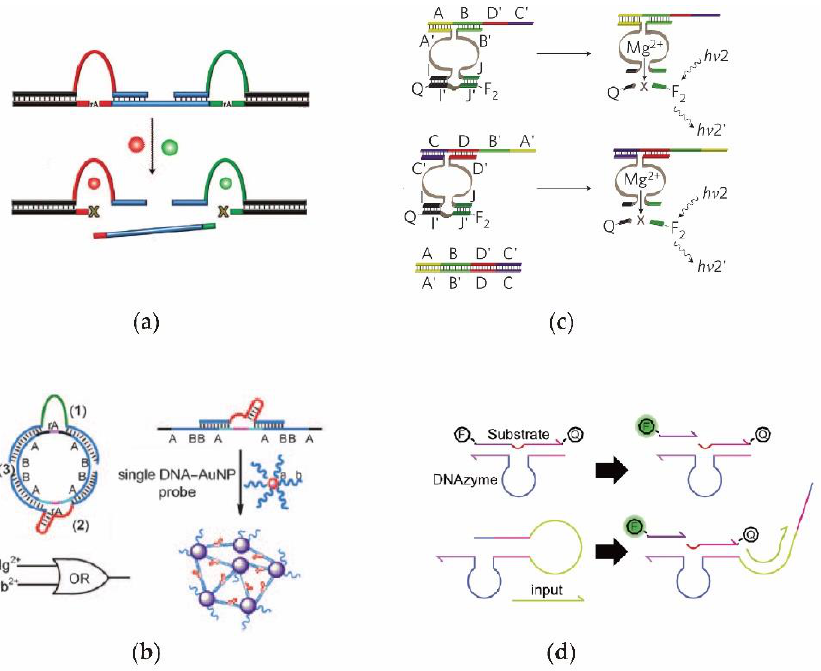
Figure 3. Schematic diagrams of DNAzyme-based synthetic DNA circuit. ( a ) DNAzyme DNA circuit able to recognize metal ions. ( b ) DNAzyme DNA circuit to realize controllable self-assembly of nanoparticles to construct logic gates. ( c ) Editable DNA circuit constructed by the combinations of variable DNA scaffolds. ( d ) Controllable DNAzyme switches with repeated open/off control.